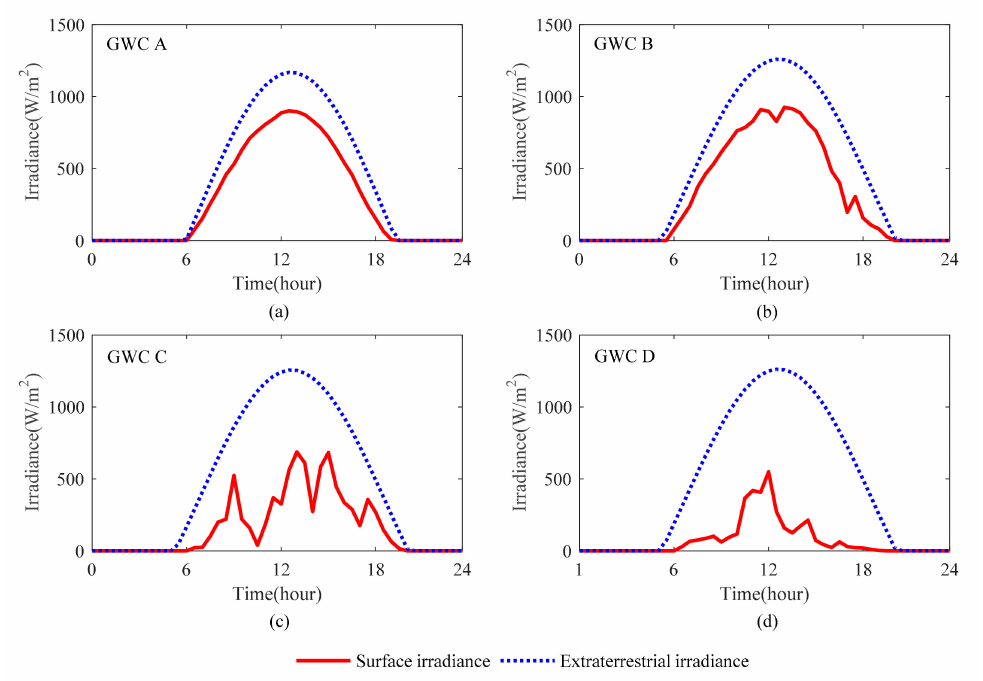
Figure 8. Typical solar irradiance curves of four GWCs. ( a ) Solar irradiance curves of GWC A; ( b ) Solar irradiance curves of GWC B; ( c ) Solar irradiance curves of GWC C; ( d ) Solar irradiance curves of GWC